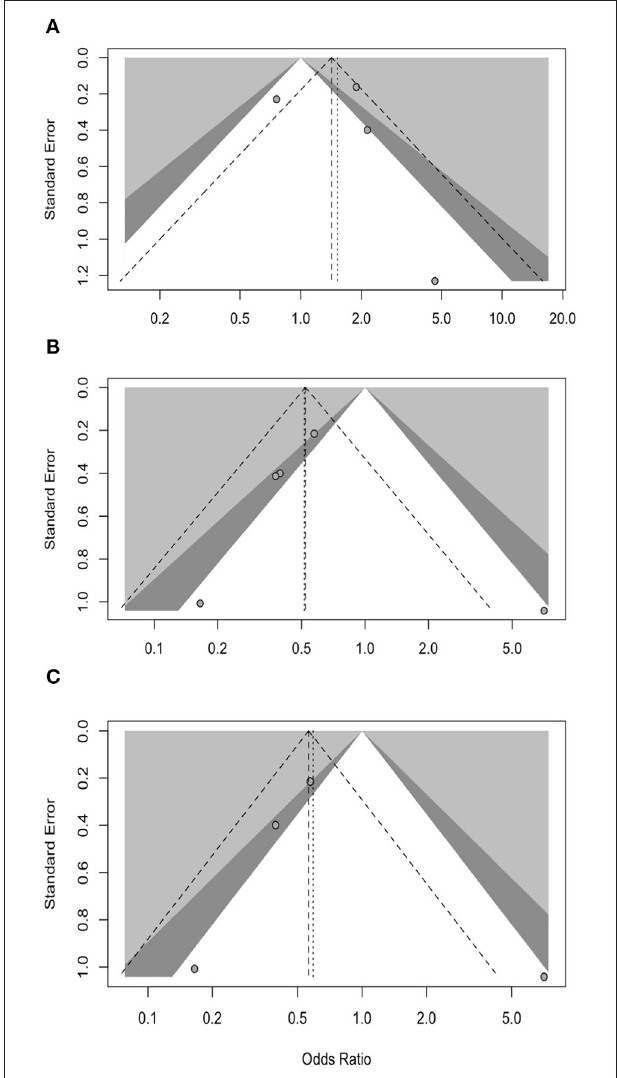
FIGURE 5 | Border-enhanced funnel plots for studies included in the meta-analysis: (A) case-control studies comparing positive cases among injured workers vs. positive controls from general population; (B) cross-sectional studies comparing positive cases in occupational injuries vs. non-occupational injuries; (C) cross-sectional studies comparing positive cases in occupational injuries vs. non-occupational injuries including only laboratory-based